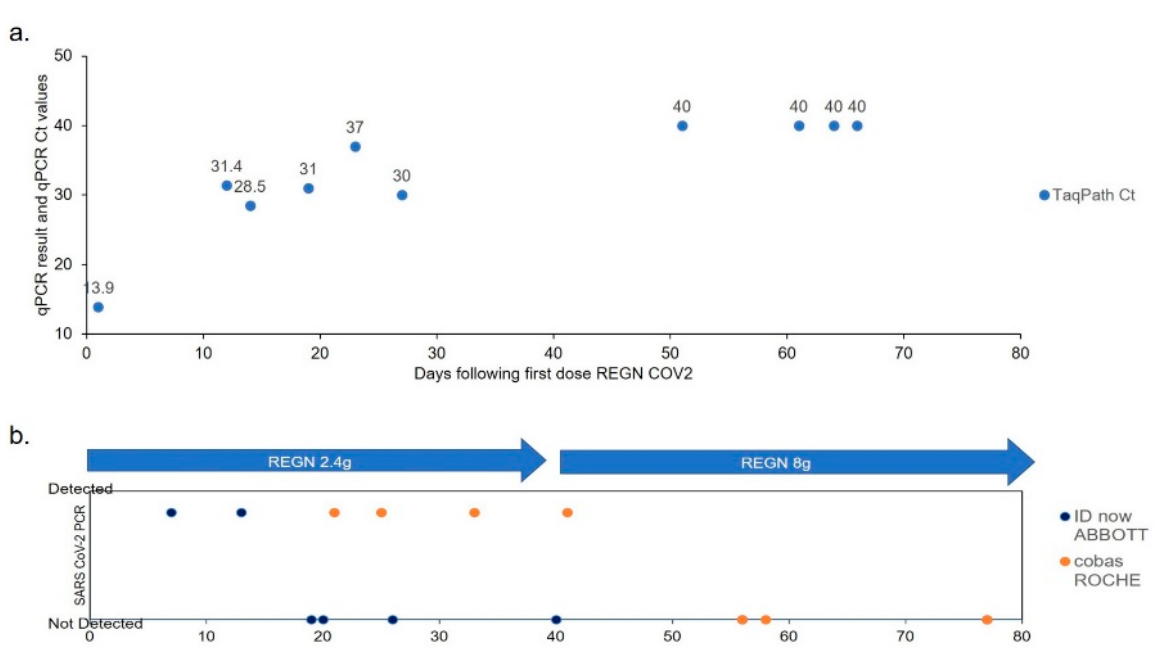
Figure 2. SARS-CoV-2 qRT-PCR results following REGEN-COV anti-spike MoAb infusions . ( a ) TaqPath Ct values. ( b ) IDnow and cobas Roche results. First dose infusion day 0. TaqPath Ct < 37 detected; Ct > 37 not detected. IDnow and cobas not detected vs. detected.